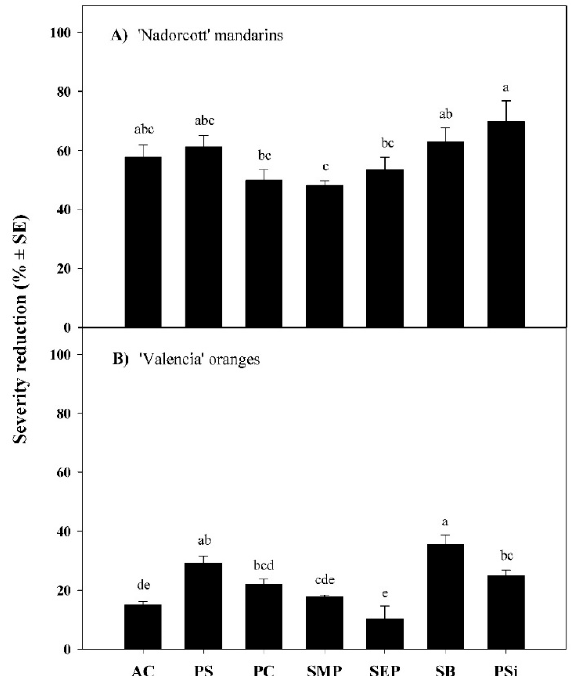
Figure 1. Percentage reduction of anthracnose severity (lesion diameter) with respect to control fruits on “Nadorcott” mandarins ( A ) and “Valencia” oranges ( B ) artificially inoculated with Colletotrichum gloeosporioides and coated 24 h later with hydroxypropyl methylcellulose (HPMC)-beeswax (BW) composite edible coatings containing GRAS salts and incubated for 15 d at 25 °C and 90% RH. Represented GRAS salts and concentrations are: 0.2% ammonium carbonate (AC), 2% potassium sorbate (PS), 0.2% potassium carbonate (PC), 0.1% sodium methylparaben (SMP), 0.1% sodium ethylparaben (SEP), 2% sodium benzoate and 2% potassium silicate (PSi). Average data from two trials with each citrus species. In every trial, each treatment was applied to four replications of 10 fruits each. Average severity of uncoated controls was: A) mandarins = 47.29 mm, B) oranges = 15.2 mm. Columns with different letters are significantly different according to Fisher’s protected LSD test ( P < 0.05) applied after the ANOVA.